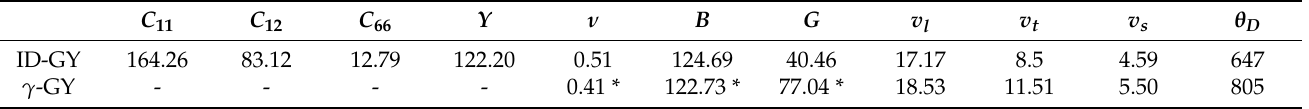
Table 1. Calculated elastic coefficients C ij (in N/m), Young’s modulus Y (in N/m), Poisson’s ratio ν , bulk modulus B (in N/m), shear modulus G (in N/m), longitudinal sound velocity v l (in km/s), transverse sound velocity v t (in km/s), average sound velocity vs. (in km/s), and Debye temperature θ D (in K) for ID-GY. For comparison, the corresponding values for γ -graphyne ( γ -GY) are also listed here.